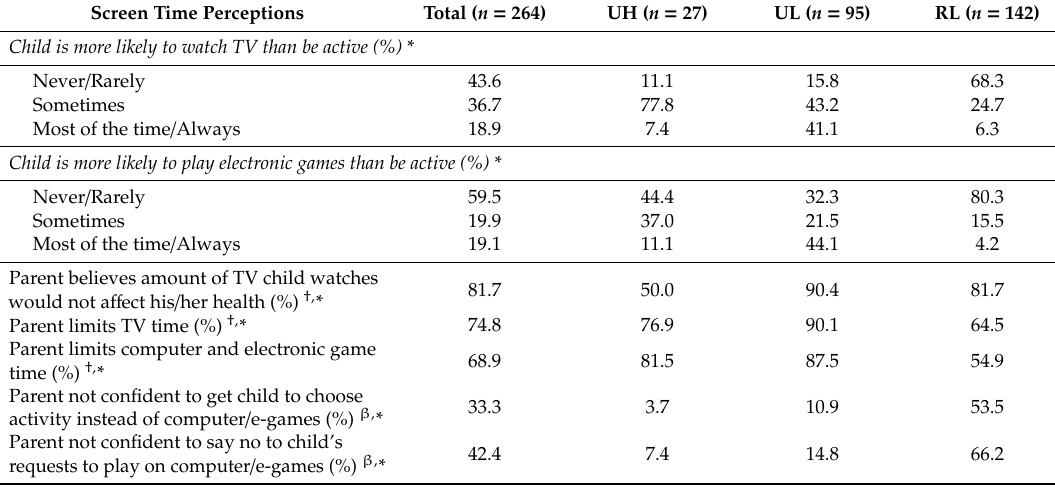
Table 3. Parent perceptions of preschool child’s screen time.